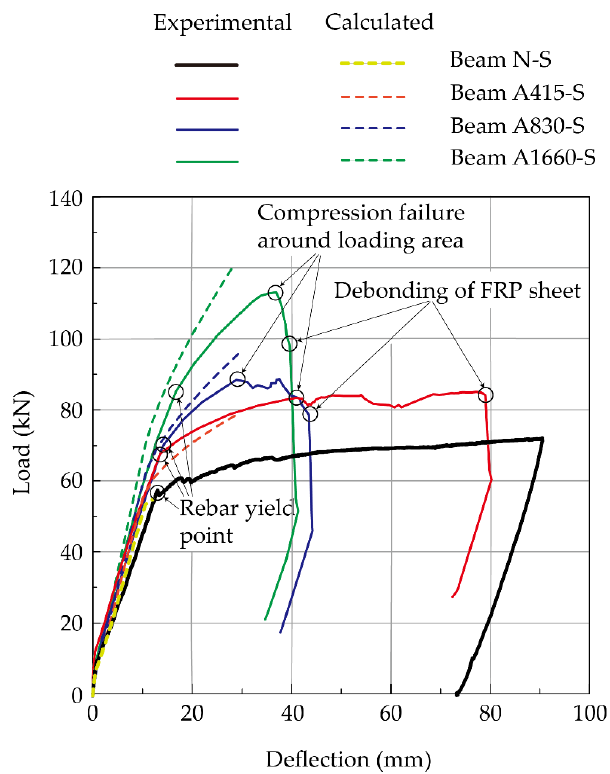
Figure 6. Comparison of the load-deflection relationship for the beams under static loading.